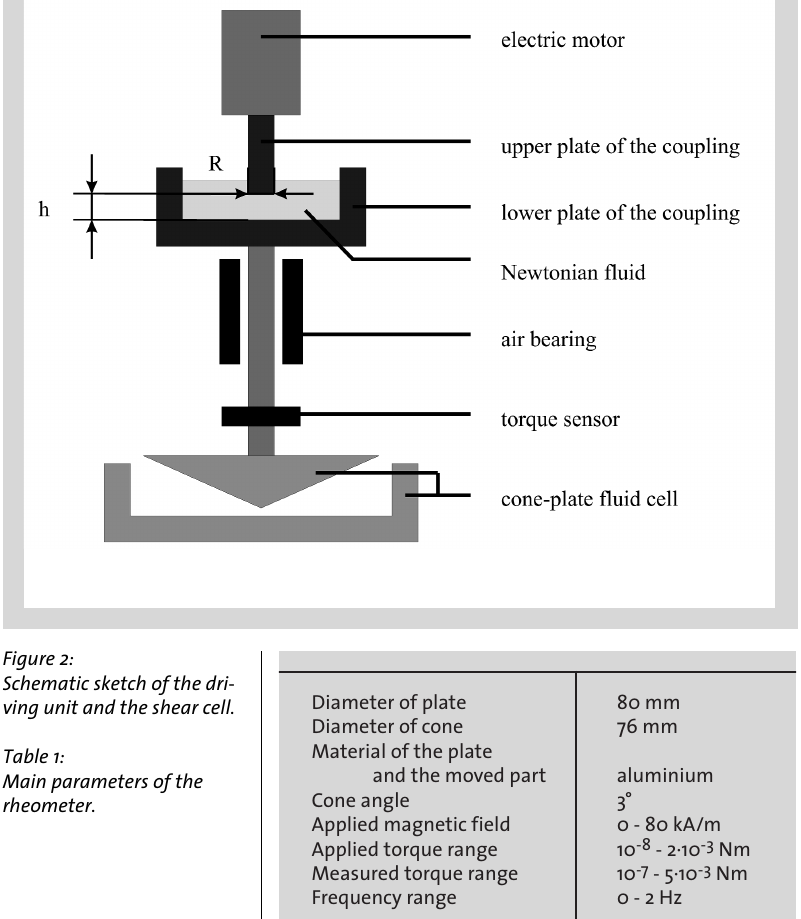
Figure 2: Schematic sketch of the dri- ving unit and the shear cell. Table 1: Main parameters of the